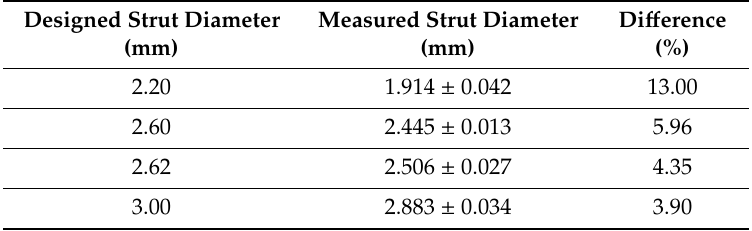
Table 2. Variation in the fabricated and designed diameter of the struts.